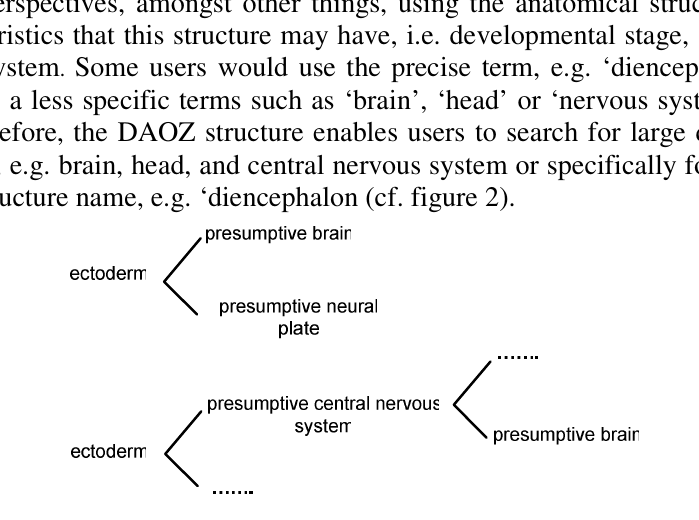
Figure 1: At ‘75% epiboly’ is the presumptive brain part of the ectoderm, while at stage ‘1 somite’ it becomes part of the presumptive central nervous